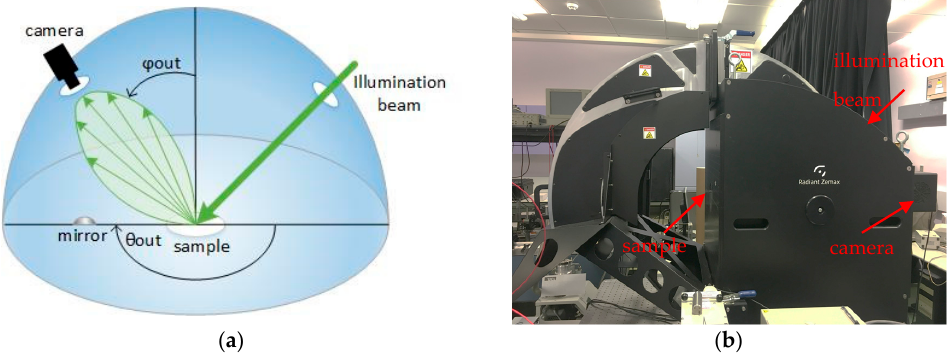
Figure 2. Imaging sphere ( a ) configuration where θ out and φ out shows the azimuth and elevation angles of reflected radiation; ( b ) Photograph.